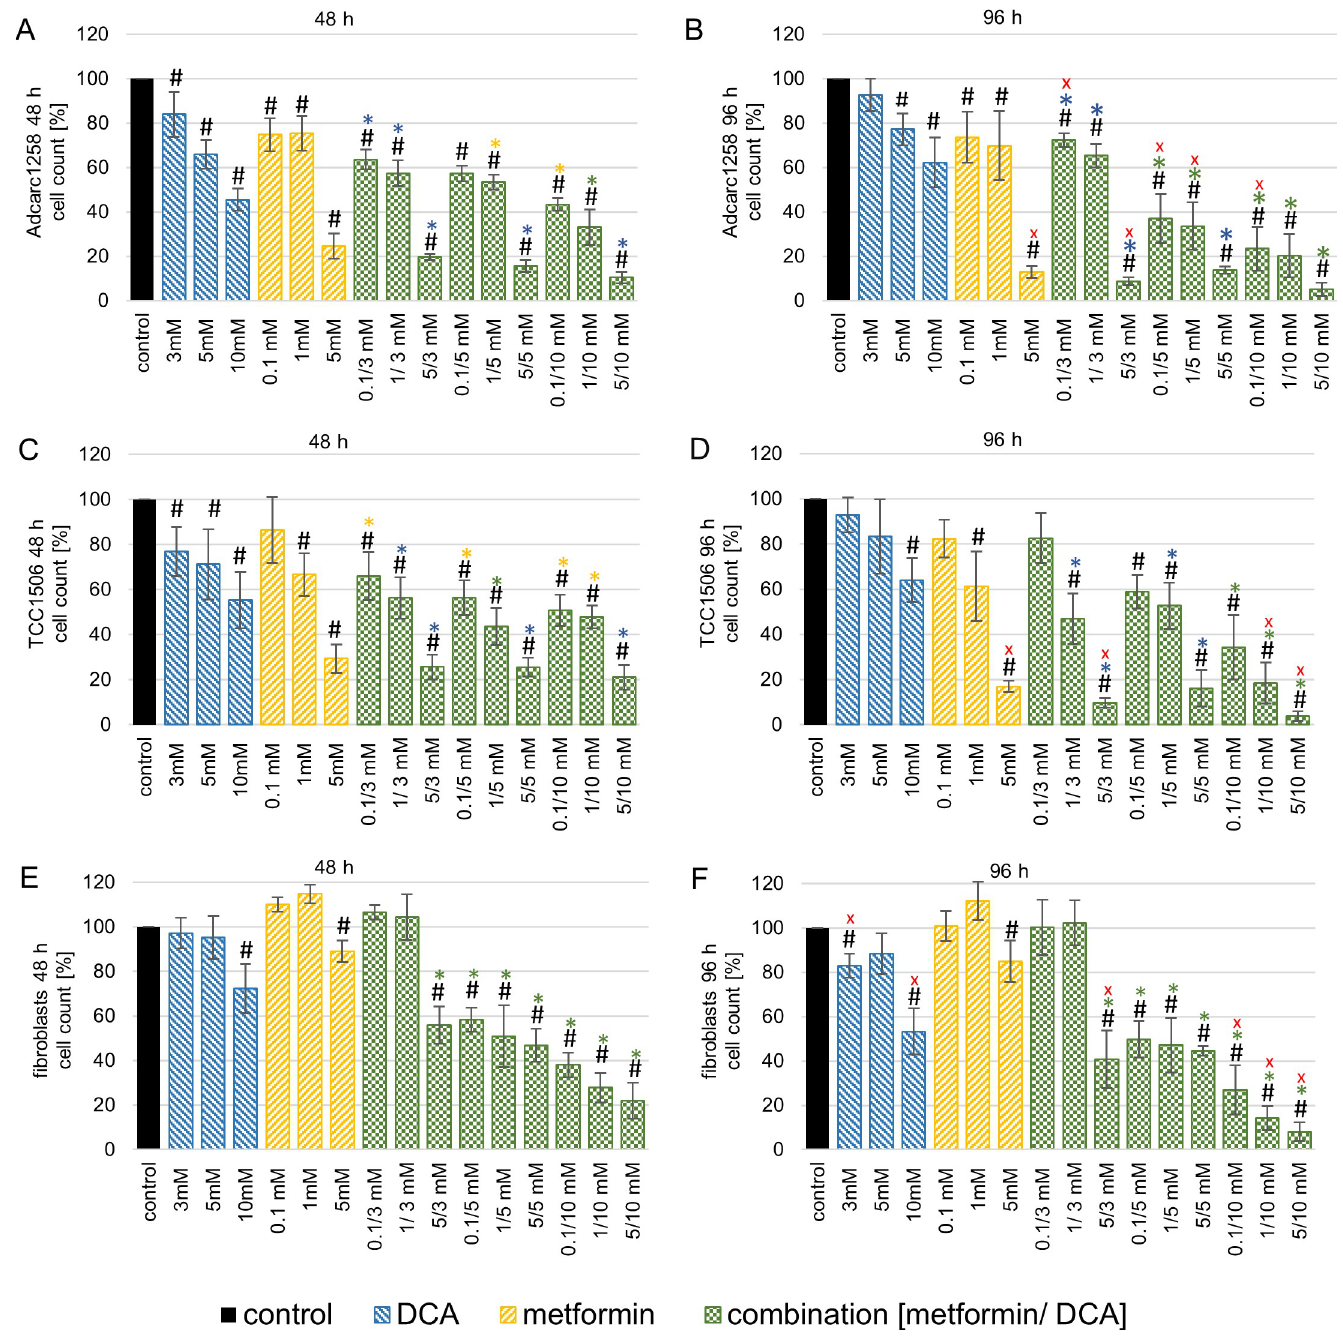
Fig 2. Cell count of Adcarc1258 (A and B), TCC1506 (C and D and, fibroblasts (E and F) after exposure to DCA, metformin or the combination (metformin + DCA) over 48 h (A, C, and E) and 96 h (B, D, and F). All values are expressed as a percentage of the untreated control cells of the respective cell line. Means and standard deviations are displayed, n = 3. Blue asterisks: significant difference between combination and respective single DCA application. Yellow asterisks: significant difference between combination and respective single metformin application. Green asterisks: significant difference between combination and the respective single application of DCA and metformin. Red x: significant difference referred to the respective value after 48 h exposure. Black number signs: significant difference in comparison to the control. Significance is set at p < 0.05.